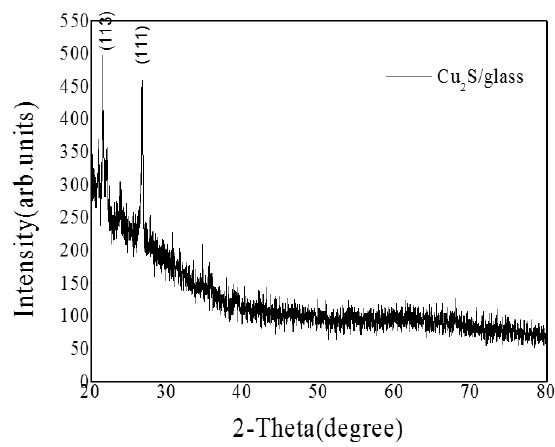
Figure 8. The XRD patterns of Cu 2 S/glass films.